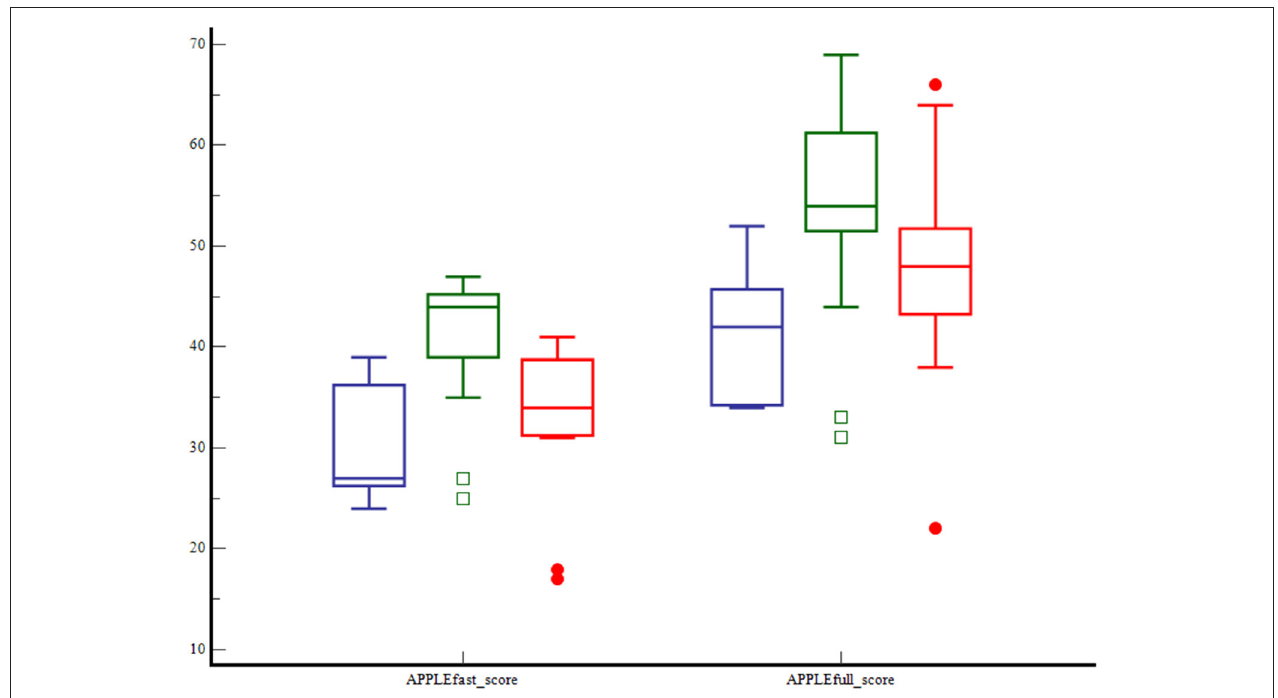
FIGURE 1 | Box and whisker plots comparing the APPLE fast and APPLE full scores among cats with cryptic shock ( n = 7, in blue), dysoxic shock ( n = 17, in green), and vasoplegic shock ( n = 11, in red). The central lines represent the median, the boundaries of the boxes represent the interquartile range and the whiskers represent the minimum and maximum values. Cats with dysoxic shock had significantly higher APPLE fast and APPLE full scores compared to cats with cryptic and vasoplegic shock ( P < 0.001 and P < 0.015, respectively).